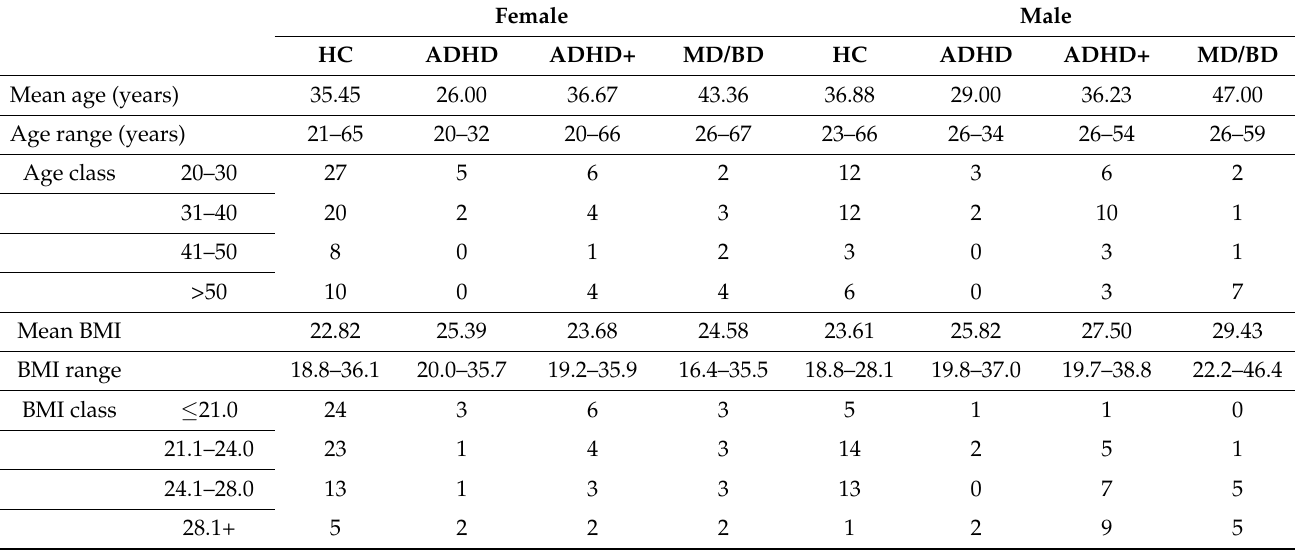
Table 1. Demographic data of healthy controls (HC) and patients with ADHD, ADHD+. Or MD/BD. Female Male HC